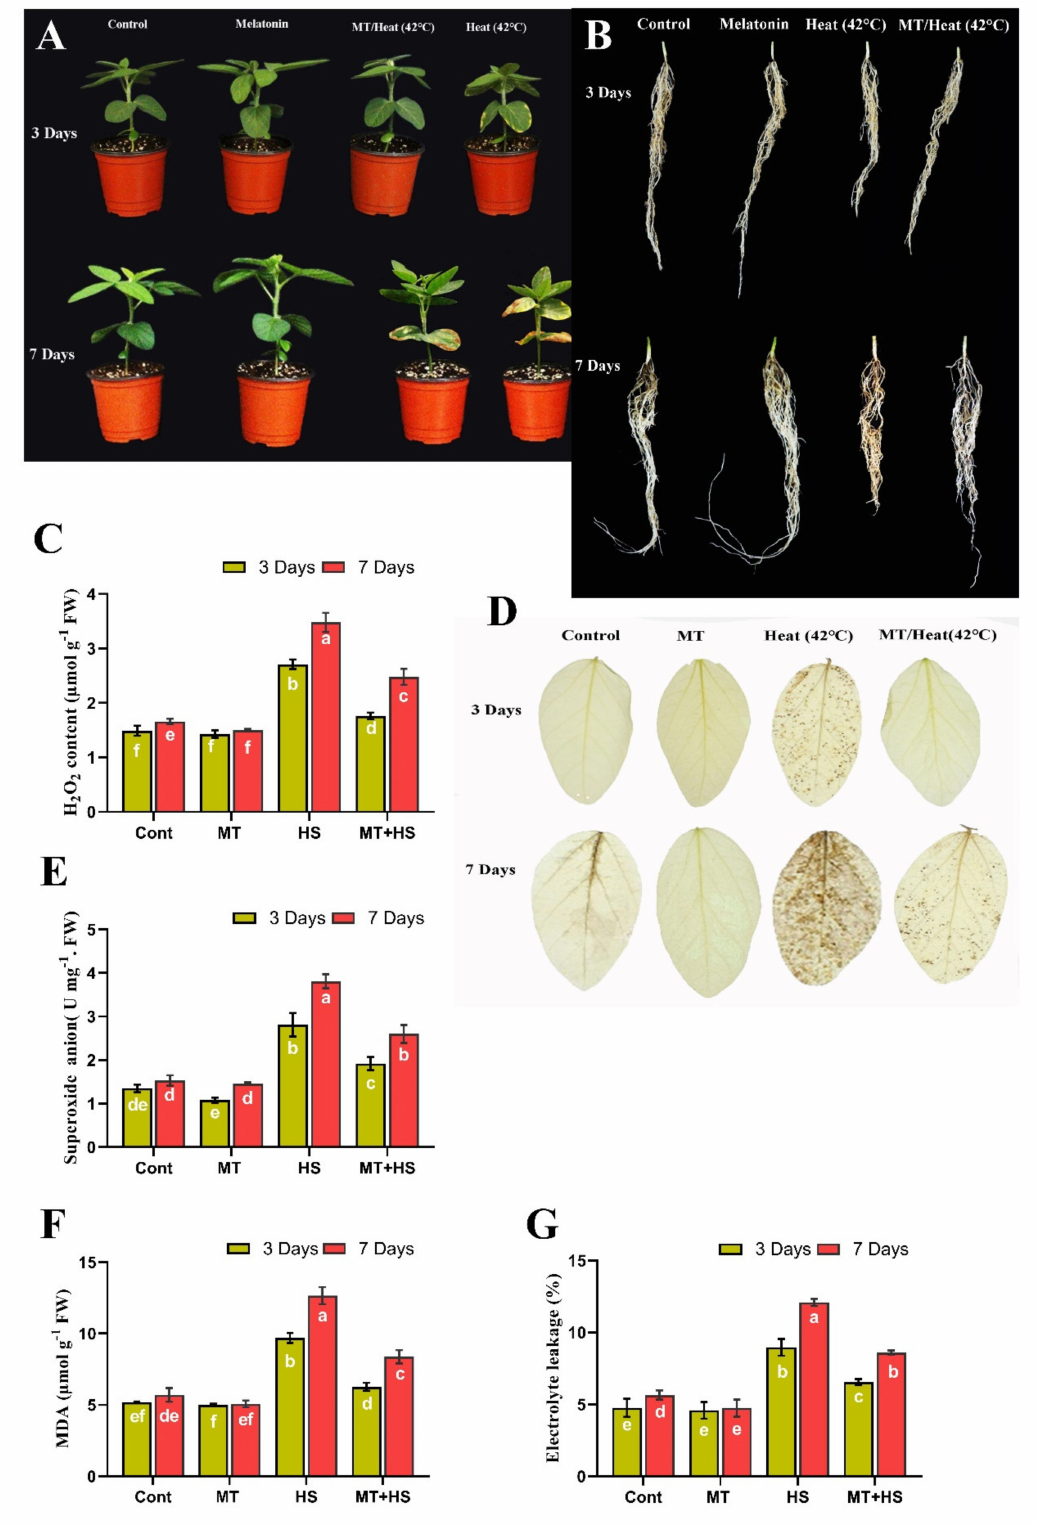
Figure 1. Effects of melatonin application with or without high temperature (42 ◦ C) in soybean seedling after 3 and 7 days, phenotypical visualization of ( A ) shoot ( B ) root, ( C ) hydrogen peroxide, ( D ) DAB staining, ( E ) superoxide anion, ( F ) MDA level, and ( G ) electrolyte leakage. Each data point is the mean of three replicates. Error bars represent the standard error of the mean. Bars with different letters are significantly different from each other by Duncan’s multiple range test at p ≤